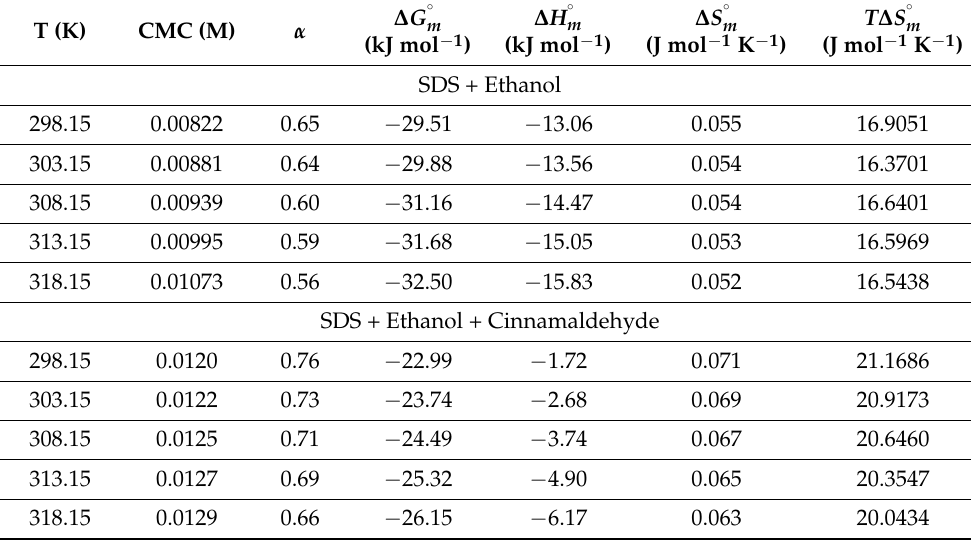
Table 1. The thermodynamic parameters of micellization at different temperatures (298.15 K to 318.15 K) for SDS + E-OH and SDS + E-OH + CAD,